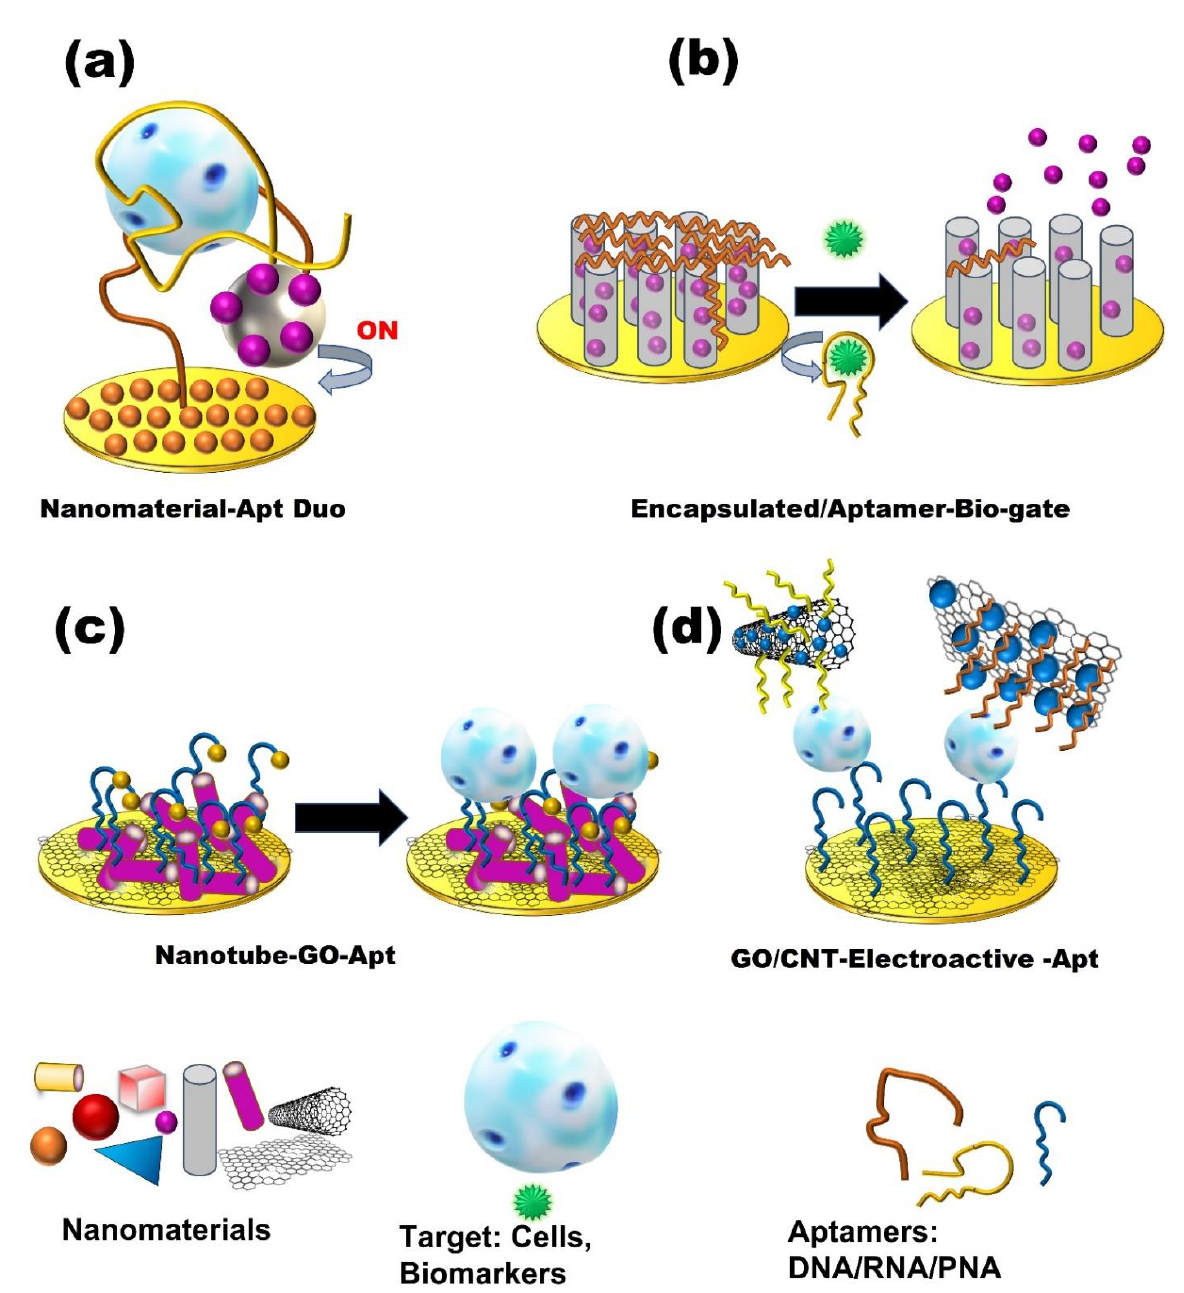
Figure 2. Schematic presentation of nanomaterials-based Aptasensors. ( a ) Nanomaterial–Aptamer Duo sandwich-type aptasensors. ( b ) Encapsulated nanomaterials “Bio-gate” aptasensors. ( c , d ) Graphene oxide/nanotubes–electroactive aptasensors. Table 1. Various Electrochemical Aptasensors for cancer detection applications.